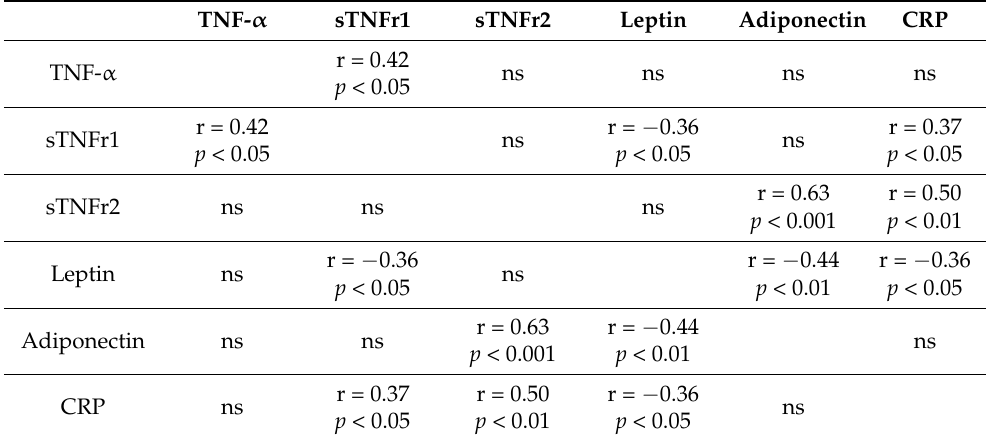
Table 3. Correlations between BMI, TNF activity and adipokines in normal-weight patients. TNF-